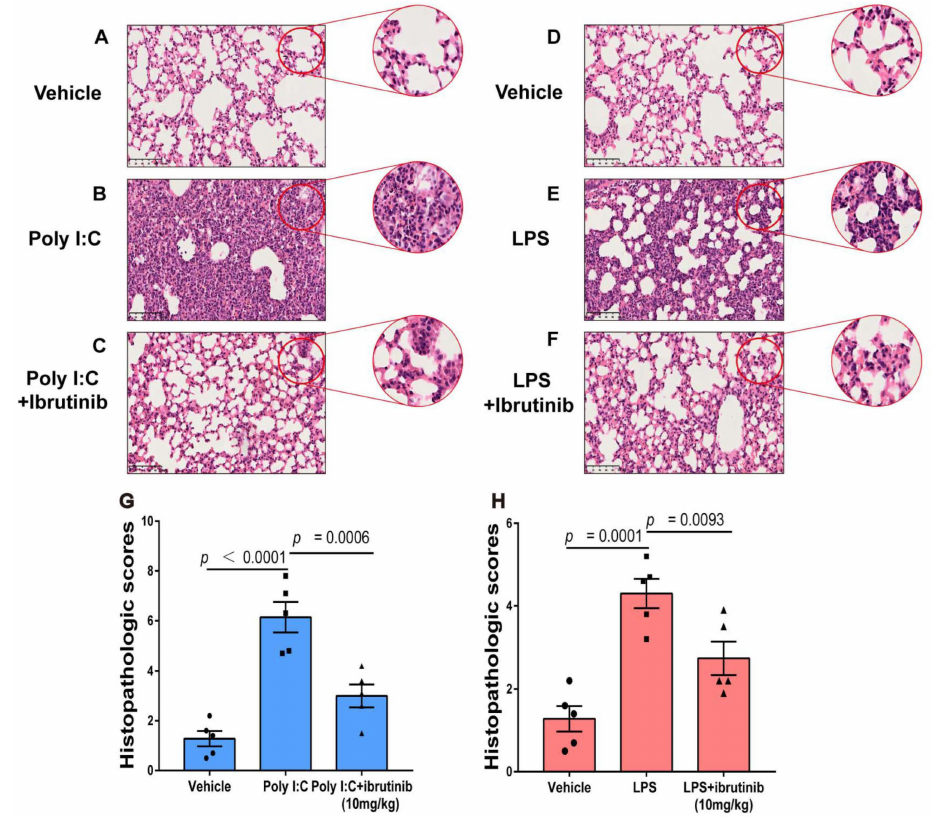
Figure 4. Effects of ibrutinib on poly I:C- and LPS-induced histopathological changes in lung tissues. ( A – C ) Representative HE images of lung sections 48 h after intratracheal poly I:C treat- ment. ( D – F ) Representative HE images of lung sections at 24 h after intratracheal LPS treatment. ( G , H ) Pathology scores for each group. The magnification was 200 × , the scale bar = 100 µ m, and all images are of the same scale. Values are shown as means ± SEM ( n =